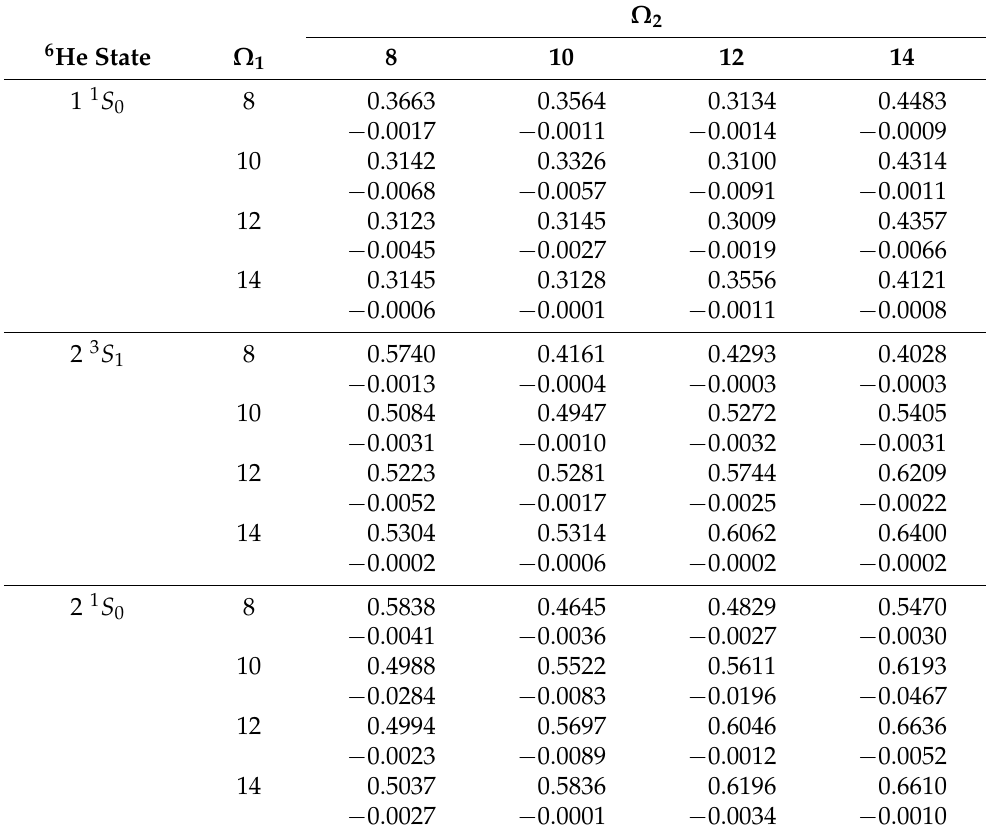
Table 2. Convergence table for the initial states 6 He(1 1 S 0 ), 6 He(2 3 S 1 ), and 6 He(2 1 S 0 ). All entries are 6 Li 3 + probabilities (taken in the limit of infinite partial waves, as shown in Figure 3) expressed in % shown for different sizes of both the projection operator ( Ω 1 ) and Hylleraas-type pseudostate ( Ω 2 ) basis sets used in Equation (23). Zeroth- and partial-second-order results from Equation (34) are at the top and bottom of each cell, respectively. The top values in the table for each state will be averaged to obtain the final 6 Li 3 + probability.